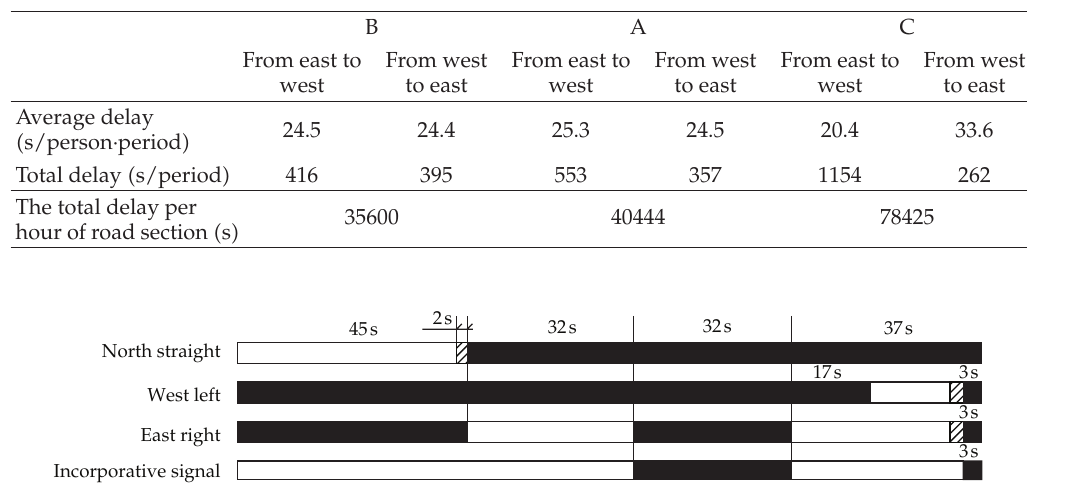
Figure 10: The merged signal of the upstream intersection into road